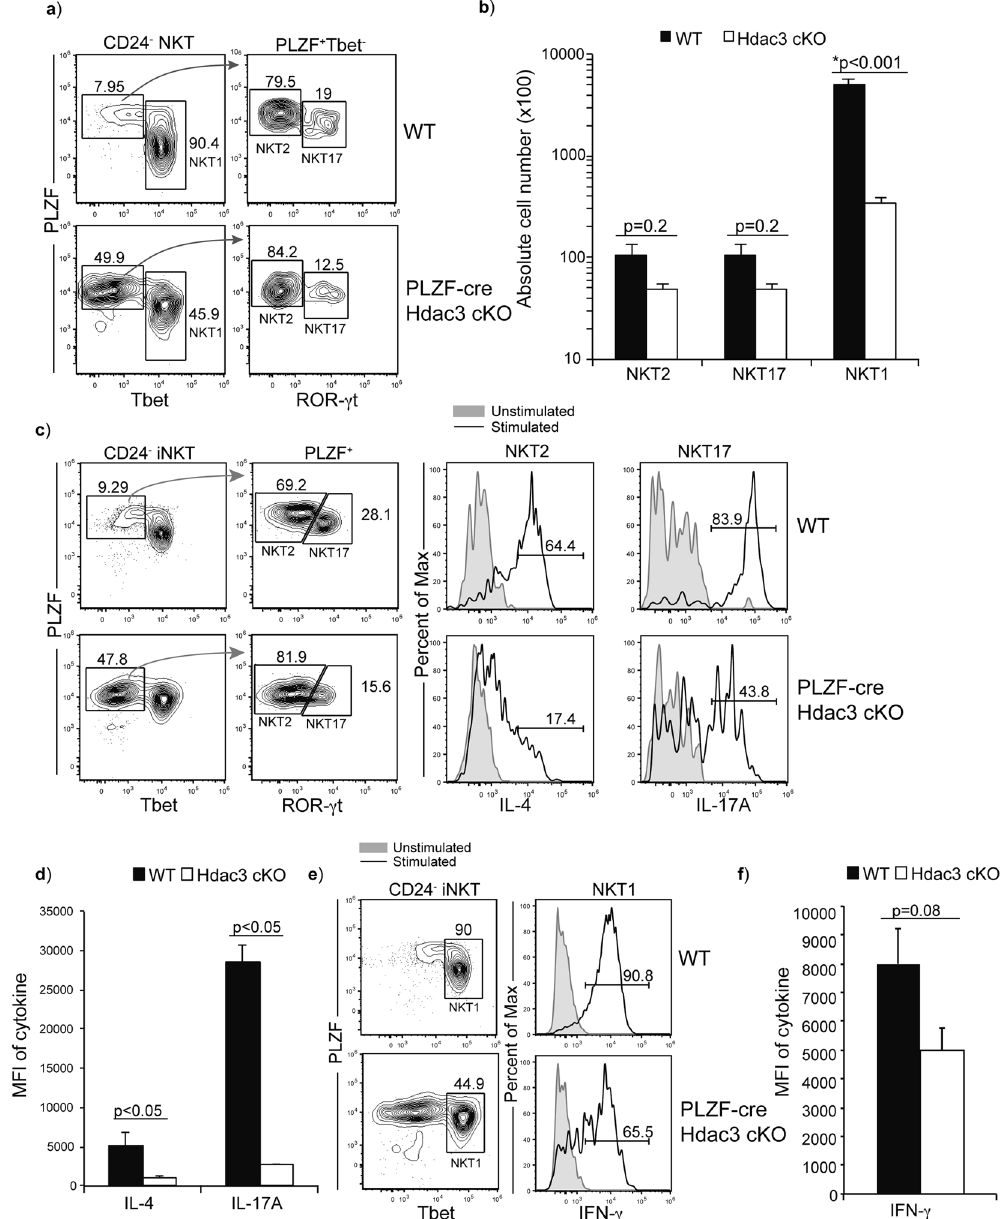
Figure 2. Hdac3-deficient iNKT cells have a defect in the differentiation of Tbet expressing NKT1. ( a ) Examination of thymic NKT subsets (NKT1, NKT2 and NKT17) as characterized by the expression of Tbet, PLZF and ROR- γ t. NKT1 (Tbet + PLZF med ), NKT2 (PLZF hi ROR- γ t − Tbet − ) and NKT17 (ROR- γ t + PLZF med Tbet − ) in WT and PLZF-cre Hdac3 cKO mice. Data is representative of at least 8 mice per genotype. ( b ) Absolute cell count for NKT2, NKT17 and NKT1 cells from WT (black bar) and PLZF-cre Hdac3 cKO (white bar) mice. Data is calculated from 14 WT and 8 PLZF-cre Hdac3 cKO mice. Statistical analysis was performed using a Student t test. Means ± SEM. ( c ) Production of IL-4 and IL-17A by stimulated (black line) and unstimulated (grey filled) NKT2 and NKT17 cells in the WT and PLZF-cre Hdac3 cKO after 6 hr stimulation with PMA/ionomycin. NKT subsets were defined as described in ( a ). Data is representative of at least 5 mice per genotype from 3 independent experiments. ( d ) Quantification of average MFI of IL-4 and IL-17A production by NKT2 and NKT17, respectively from WT (black bar) and PLZF-cre Hdac3 cKO (white bar). Data is calculated from 5 WT and 5 PLZF-cre Hdac3 cKO mice. Statistical analysis was performed using a Student t test. Means ± SEM. ( e ) Production of IFN- γ by stimulated (black line) and unstimulated (grey filled) NKT1 cells in the WT and PLZF-cre Hdac3 cKO after 6hr stimulation with PMA/ionomycin. NKT subsets were defined as described in ( a ). Data is representative of 5 mice per group. ( f ) Quantification of average MFI of IFN- γ production by NKT1 from WT (black bar) and PLZF-cre Hdac3 cKO (white bar) mice. Data is calculated from 5 WT and 5 PLZF-cre Hdac3 cKO mice. Statistical analysis was performed using a Student t test. Means ±